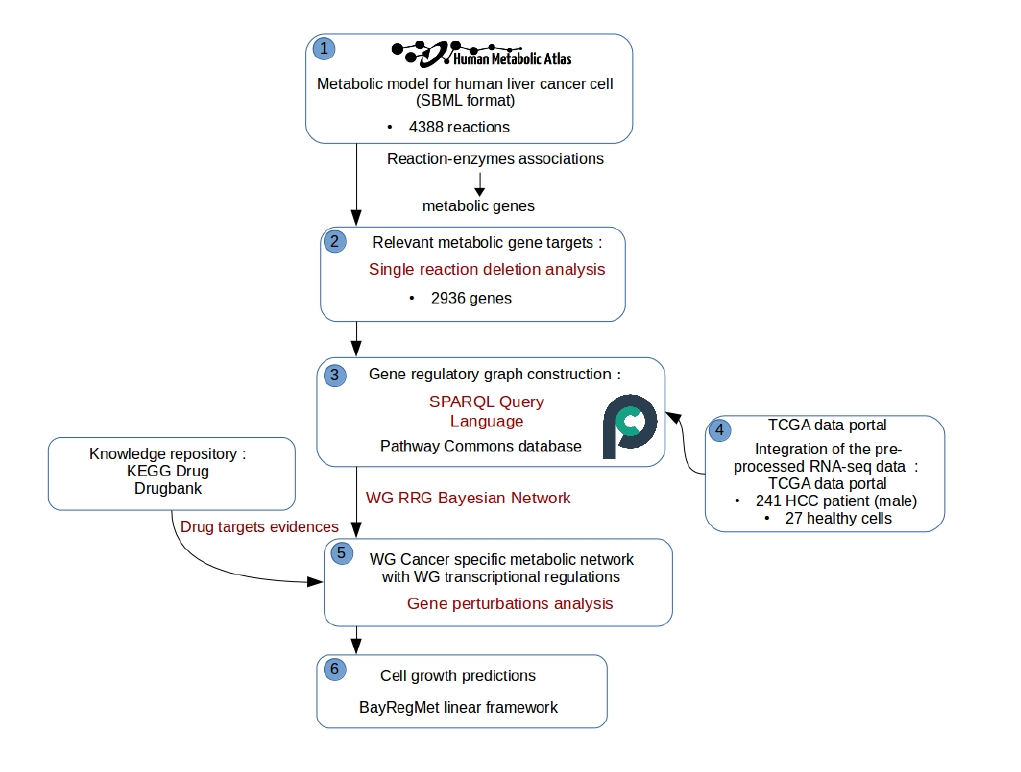
Figure 3. BayRegMet framework to study drug-induced gene perturbations at a metabolic